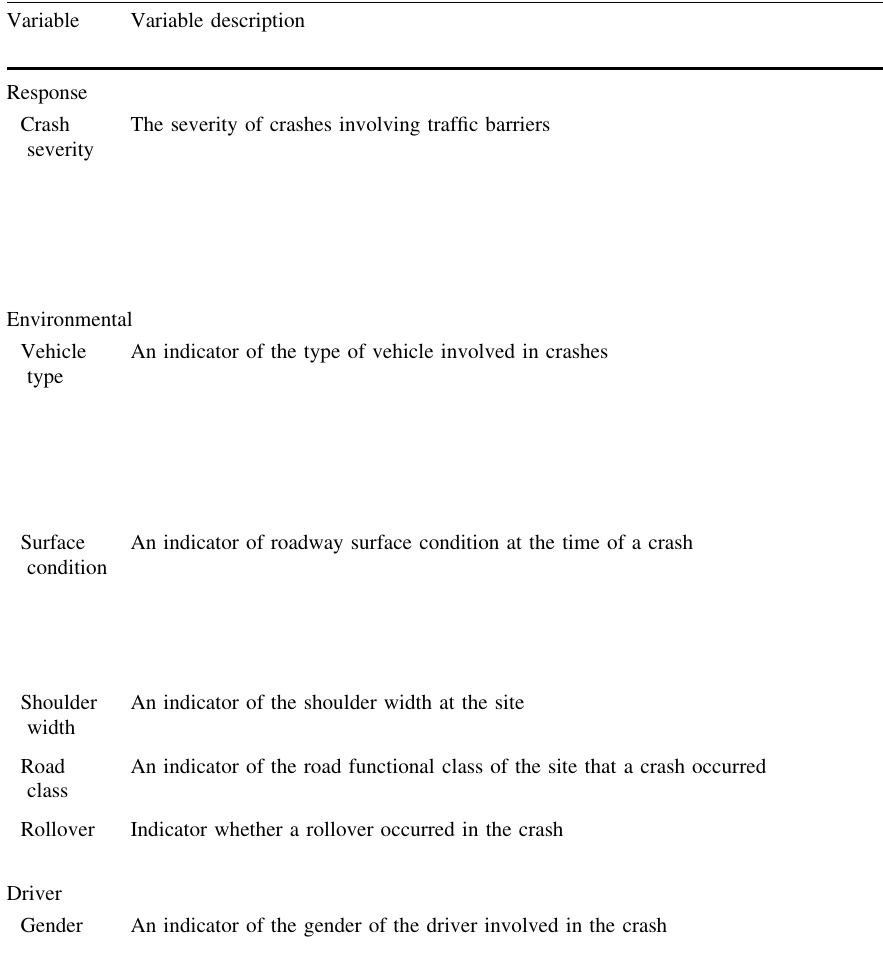
Table 1 Description of response and significant independent variables in the